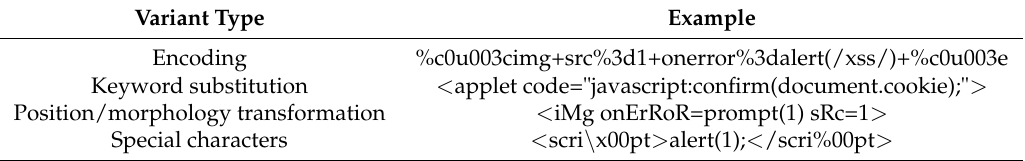
Table 2. Examples for different XSS Variant type.